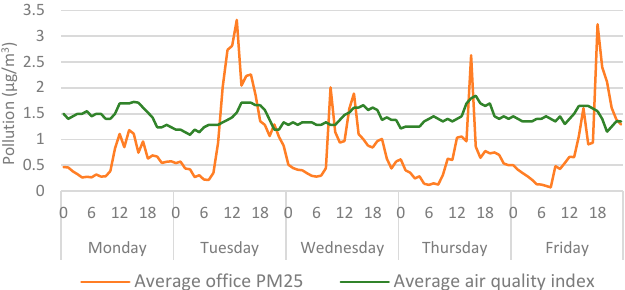
Figure 8. Average outdoor air pollution vs office particulates categorised by day > hour. Qualitative findings are displayed alongside the quantitative data for context.